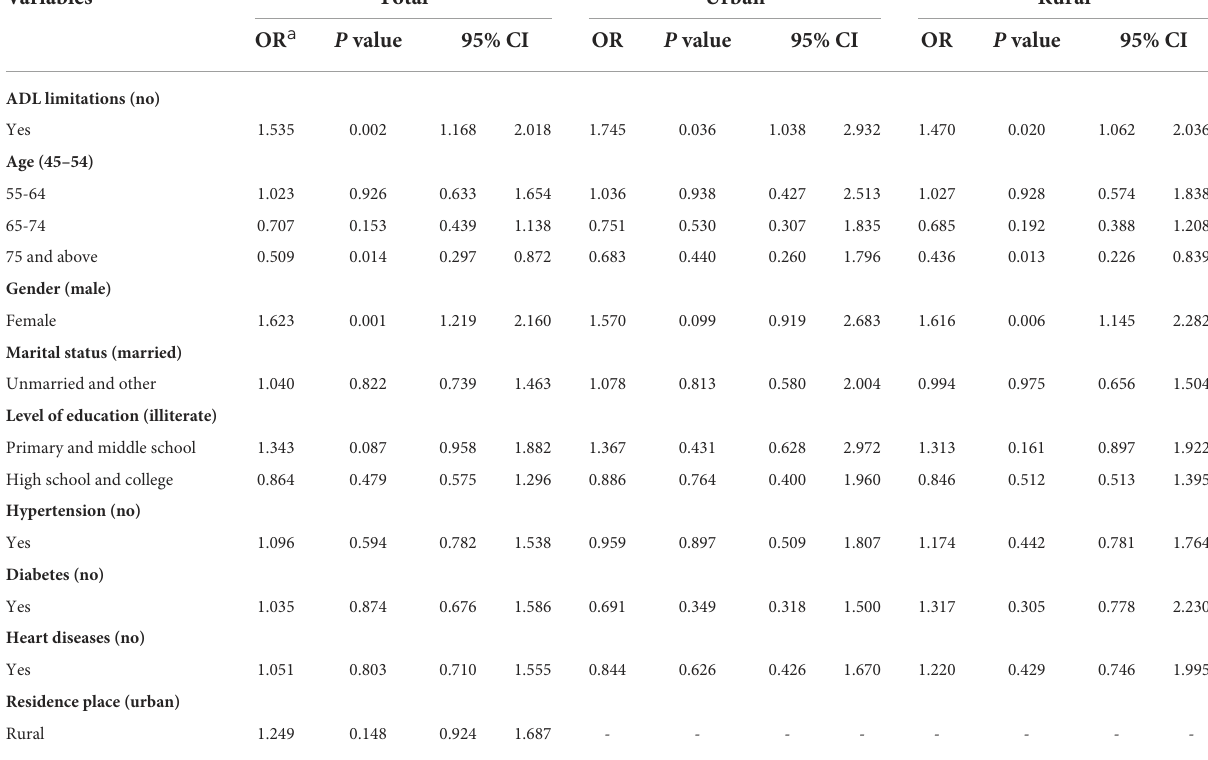
TABLE 3 Association of ADL limitations with depression among patients with stroke ( n = 969).